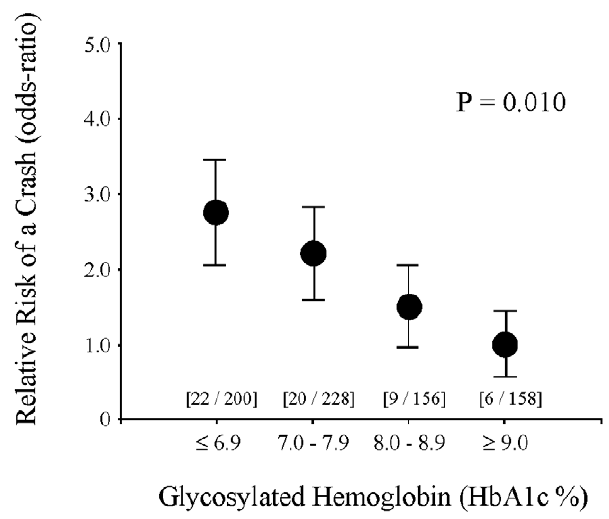
Figure 1. Glycemic control and risk of a motor vehicle crash. Relative risk of a motor vehicle crash for drivers at different levels of glycemic control. x -Axis shows glycemic control as measured by glycosylated hemoglobin concentration and grouped into approximate quartiles. Data in square brackets show individuals in each group as [numberof cases/number of controls]. y -Axis shows relative risk of a crash expressed in odds-ratio calibrated using the top glycemic quartile as referent. Solid circles indicate point-estimates and vertical lines indicate standard error bars. p -Value tests for trend across all four quartiles. Overall results show a correlation between lower HbA1c levels and higher relative risk of a crash with no evidence of a U-shaped relationship. of a crash for each 1% reduction in HbA1c (odds ratio range 1.20–